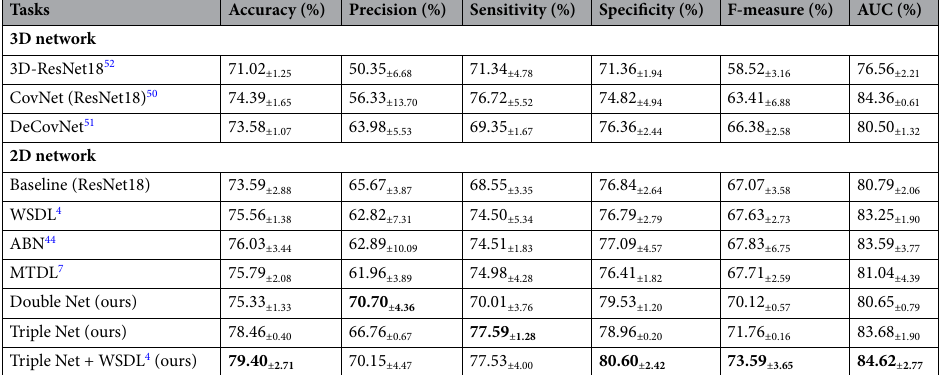
Table 2. Comparison results for binary classification.